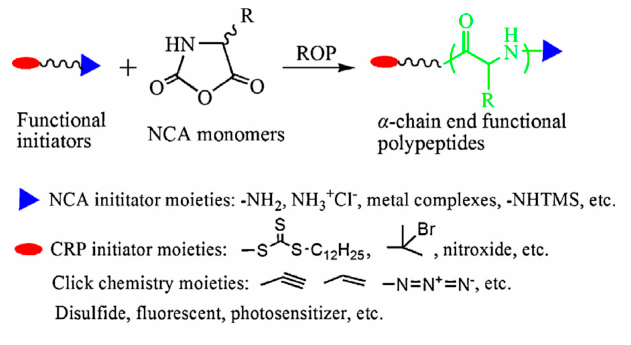
Figure 29. Alternatives to fabricate α -chain end modified polypeptides using functional initiators. Reproduced with permission from reference [31].